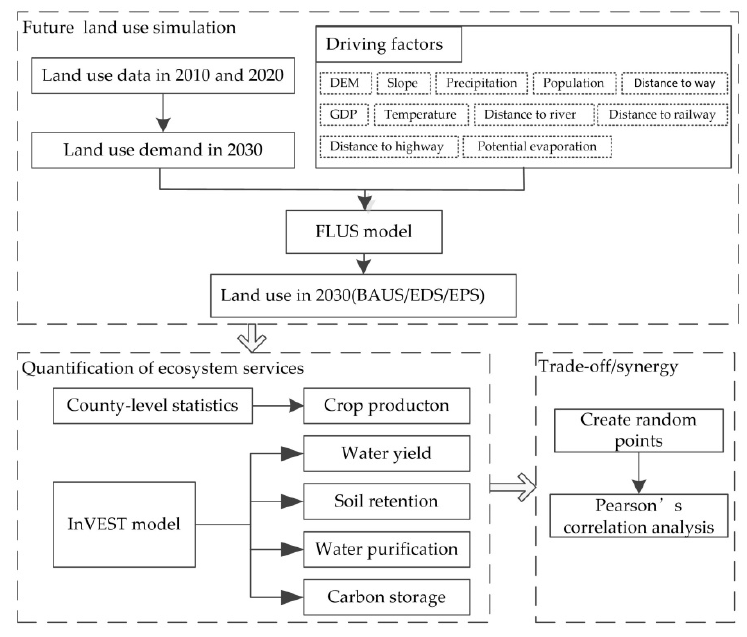
Figure 2. Framework. Figure 2.